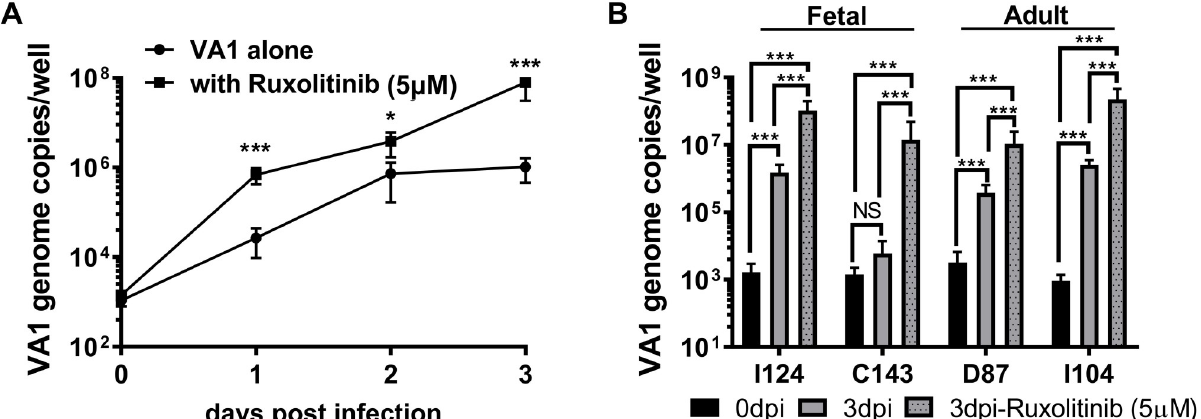
Fig 7. Inhibition of endogenous interferon responses enhances VA1 infection. A) Timecourse of VA-1 infection in the presence or absence of ruxolitinib. C68 HIE was treated with ruxolitinib (5 μ M) for 12 hrs before VA1 (MOI = 1) infection. Viral genome copies were determined by RT- qPCR from extracted RNA at days 0, 1, 2 and 3 post infection. B) The effect of ruxolitinib (5 μ M) treatment on VA1 infection of selected HIE derived from different human intestinal segments was determined at 3 dpi by RT-qPCR. Data are from � 3 experiments; error = mean ± SD. Abbreviations: D = duodenum, I = ileum, C = colon. The numbers indicate patient identifiers. NS = not significant, ��� P < 0.001.